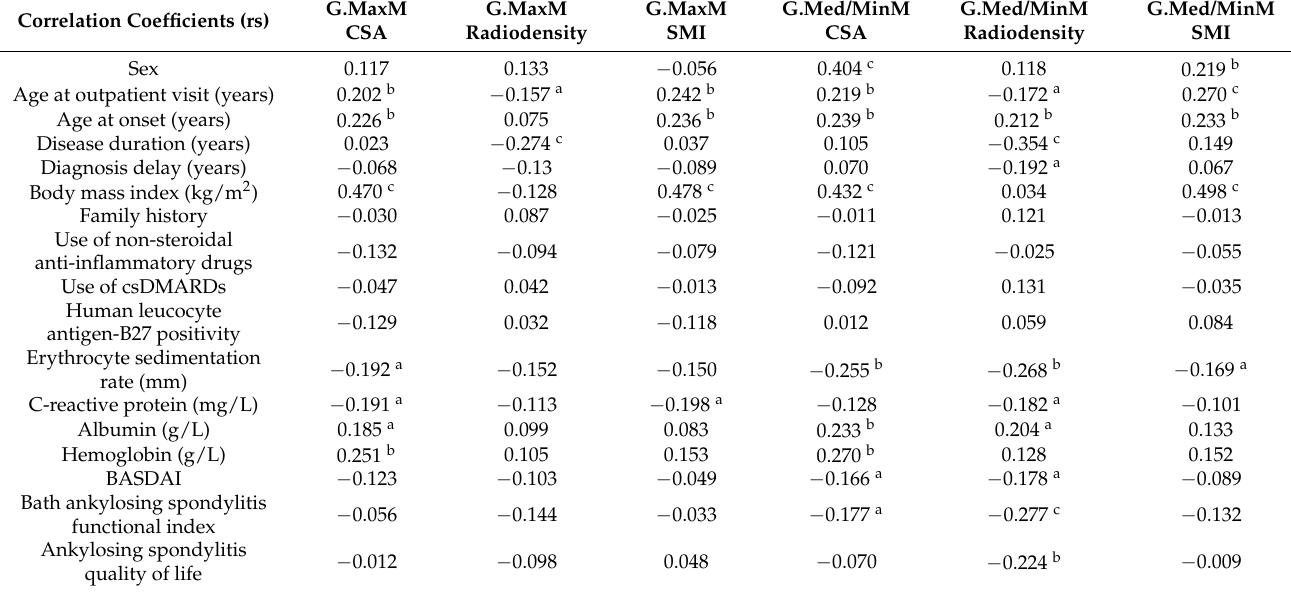
Table 4. Spearman correlation coefficients between clinical data and muscle